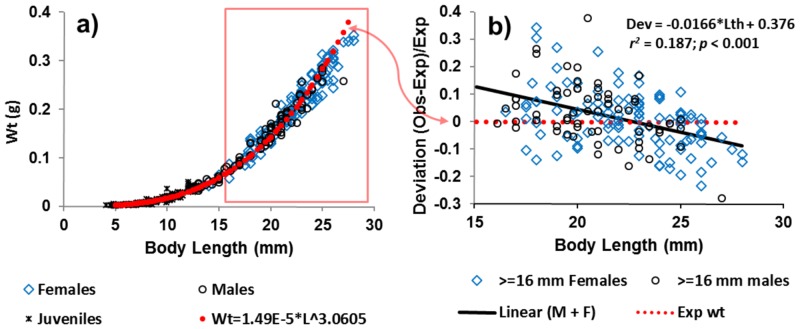
Ampelisca eschrichtii weight deviation with length.a) Estimated (red dashed line) and observed female, male, and juvenile wet weights by length (blue diamonds, black circles and orange crosses, respectively) (r2 = 0.99, df = 398, p < 0.001) collected in 2002, 2007, 2012 and 2013 with the red box enclosing greater than or equal to 16 mm males and females that; b) deviate from the expected weight (red dashes, Fig 3a and 3b) with increasing length (black line, r2 = 0.187, df = 167, p < 0.001).